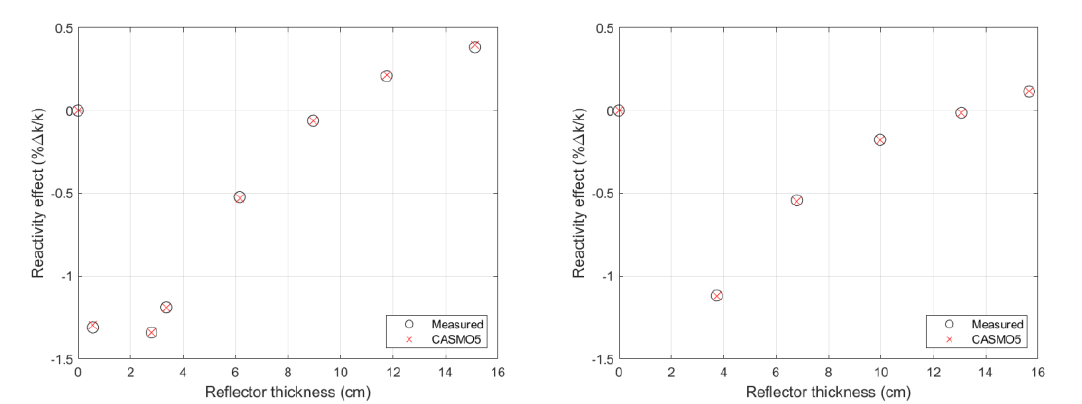
Figure 7. Reactivity effect of steel (left) and steel-water (right) reflectors in TCA experiment. The reactivity effect is the change in reactivity from the reference critical water height, which is taken from the assembly with the steel replaced by water, to the critical height with the reflector present. The ratio of the effective delayed neutron yield and mean neutron lifetime, (cid:7) (cid:8)(cid:9)(cid:9) /Λ , is also provided for the bare TCA configuration. The CASMO5 E8R0 computed (cid:7) (cid:8)(cid:9)(cid:9) /Λ is 162.8 (cid:11) (cid:12)(cid:13) , as compared to a measured value of 161.5 (cid:11) (cid:12)(cid:13) ± 5.0 (cid:11) (cid:12)(cid:13) . The CASMO5 results using the E8R0 library are comparable to those obtained using the E7R1 202